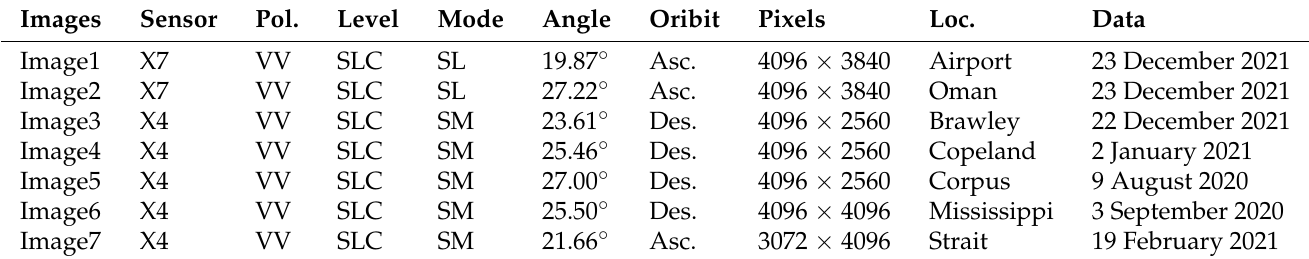
Table 1. Acquisition parameters for the ICEYE-SAR sensors.